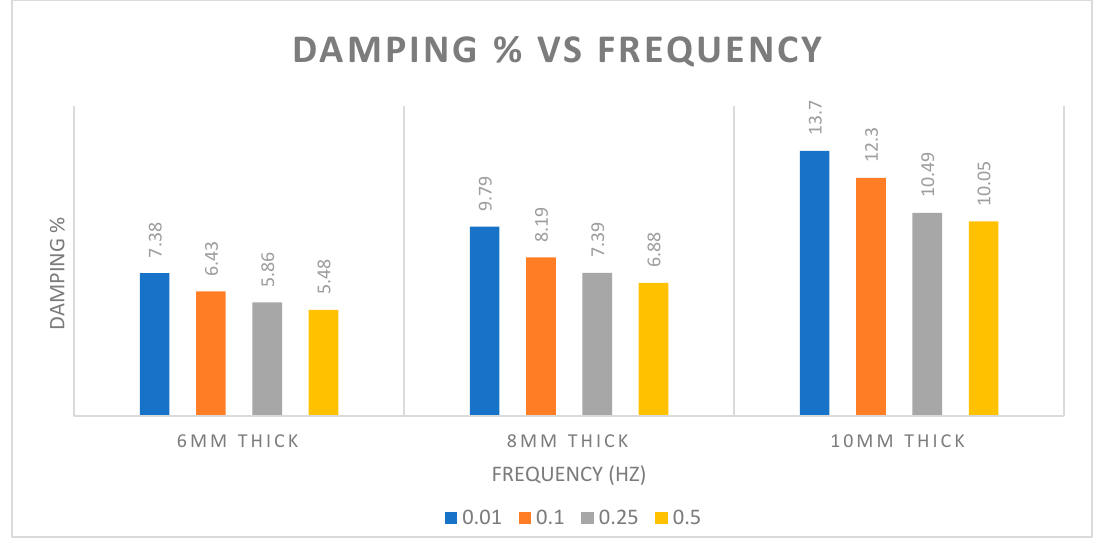
Figure 11. Plot of damping result with different thicknesses of rubber and frequencies.